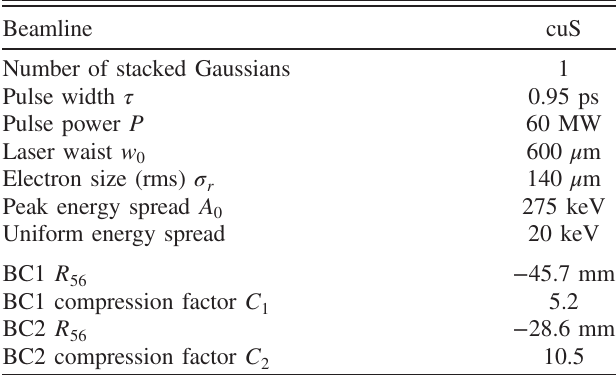
TABLE I. Laser heater shaping parameters to generate a single high-current spike at the LCLS-II cuS